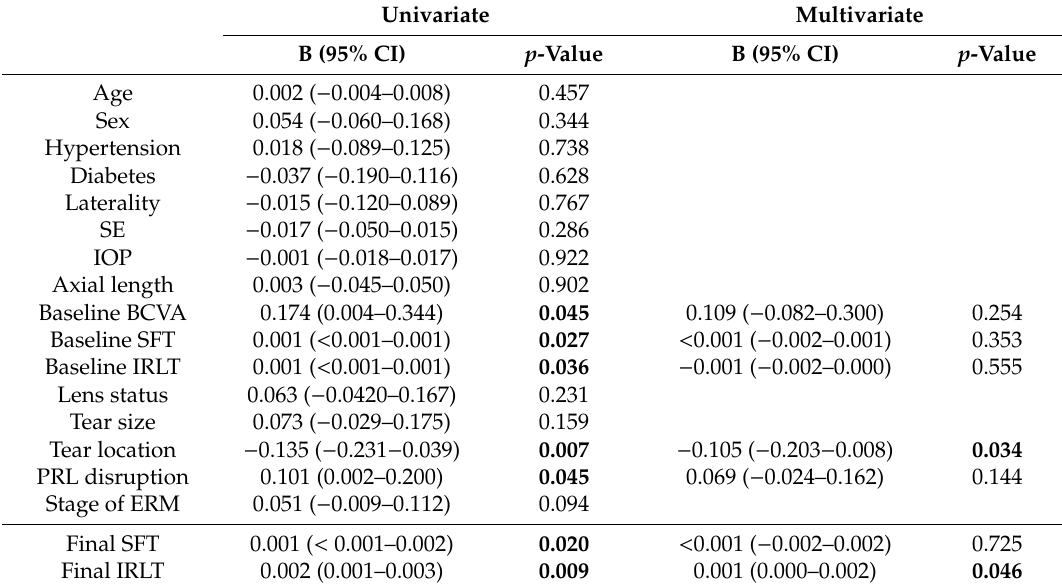
Table 4. Univariate and multivariate linear regression analyses in patients with an internal limiting membrane